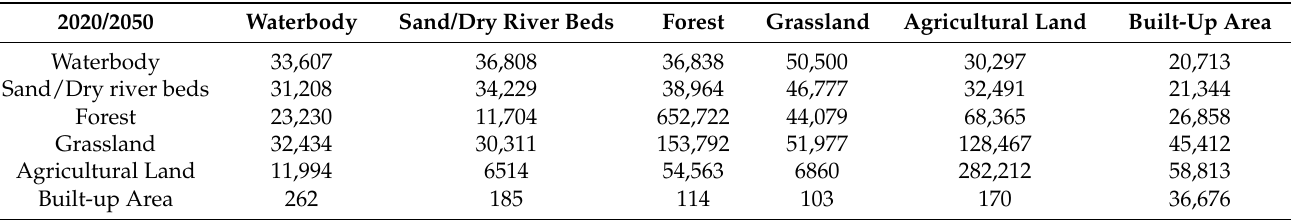
Table 11. Expected transition in 2050 by number of pixels.